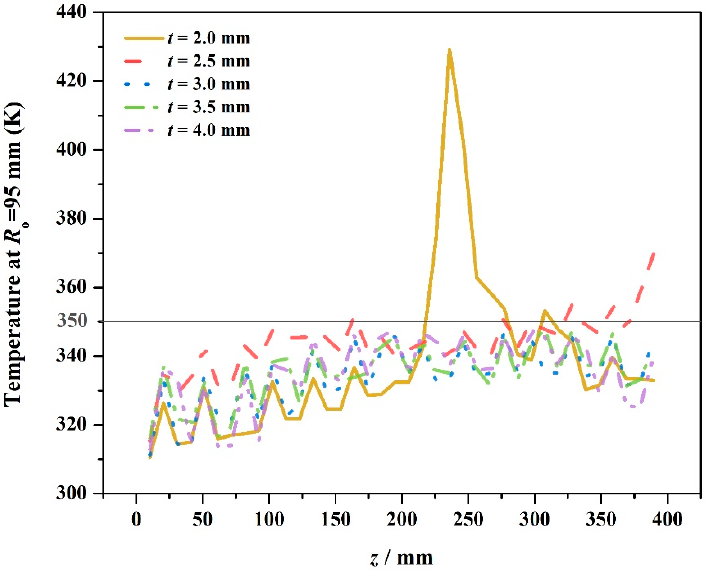
Figure 13. Temperature distribution with a fin height h = 10 mm and fin pitch p = 15 mm.